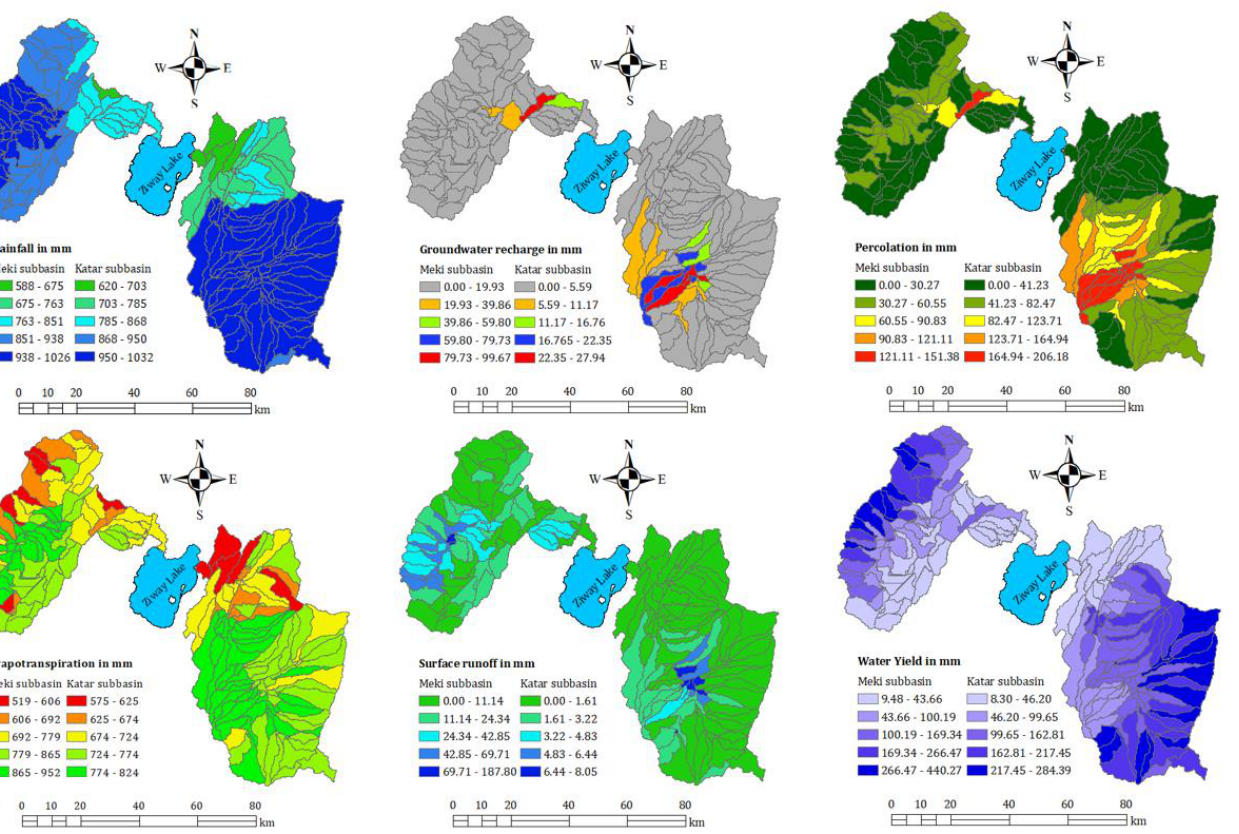
Figure 7. Spatial variation of water balance components in Katar and Meki subbasins (1999 – 2014).